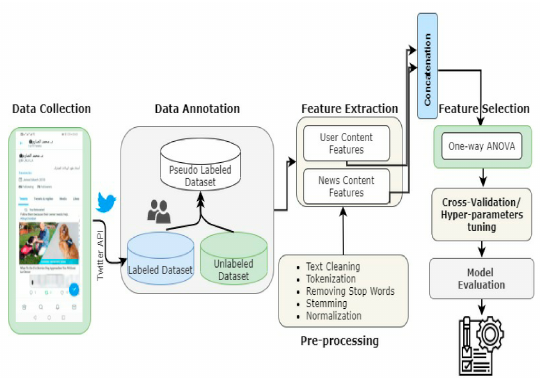
Figure 1. The proposed multiple feature approach for detection of clickbait news.